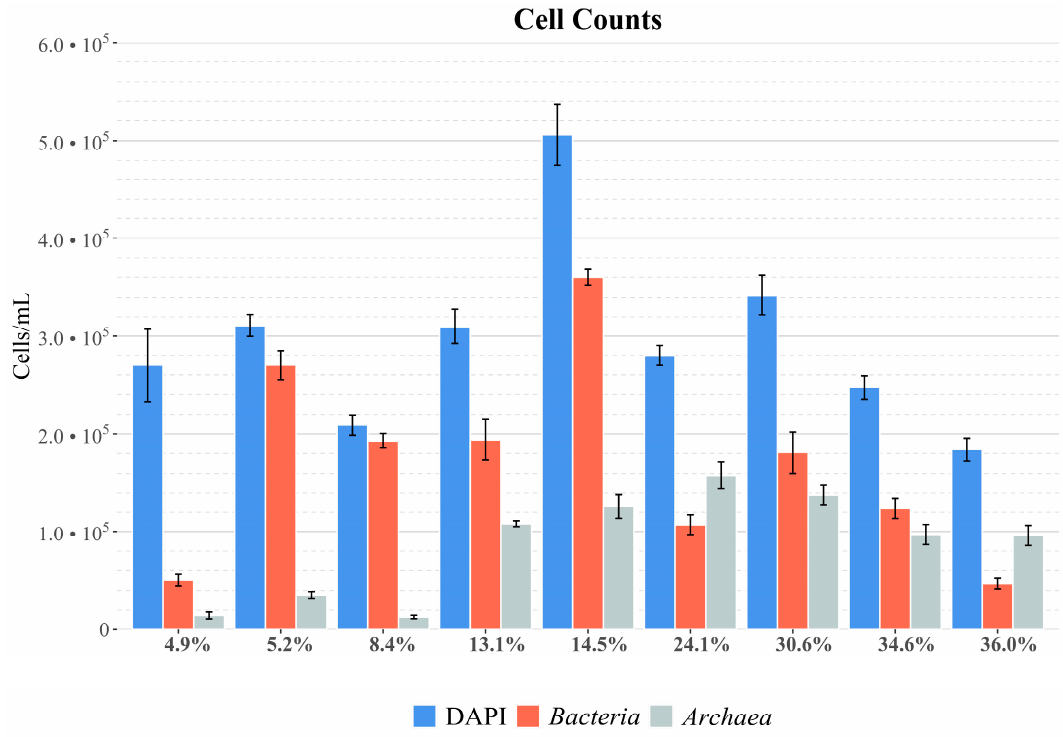
Figure 1. DAPI and CARD-FISH (catalyzed reporter deposition fluorescence in situ hybridization) analyses. Cell count values and relative abundances are reported in Table S2. Salinity is reported as salt percentage (w/v).